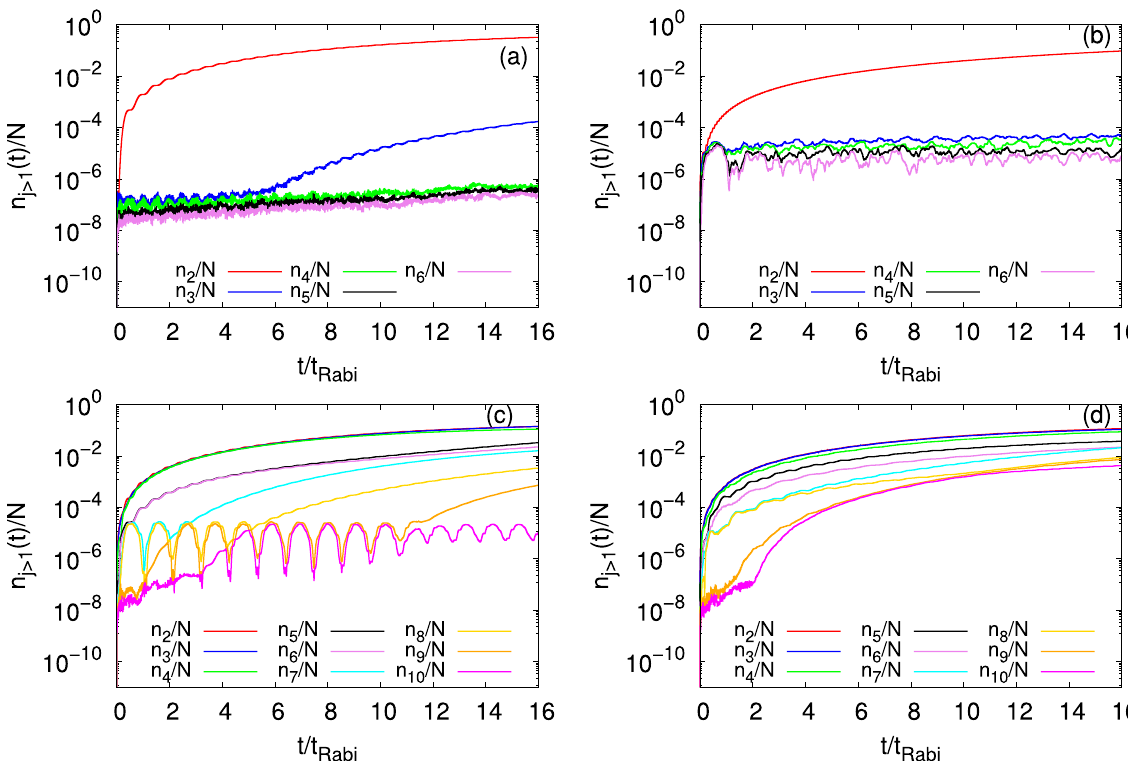
Figure 5. Details of the depletion. Time evolution of the occupation numbers per particle of the higher natural orbitals, n j > 1 ( t )/ N , in a symmetric 2D double-well for the initial states ( a ) (cid:31) G , ( b ) (cid:31) X , ( c ) (cid:31) Y , and ( d ) (cid:31) V . The 6 time-adaptive orbitals for (cid:31) results have been obtained by the MCTDHB method with M G and (cid:31) X and = 10 time-adaptive orbitals for (cid:31) M Y and (cid:31) V . See the text for more details. Color codes are explained in the = panel. The quantities shown are